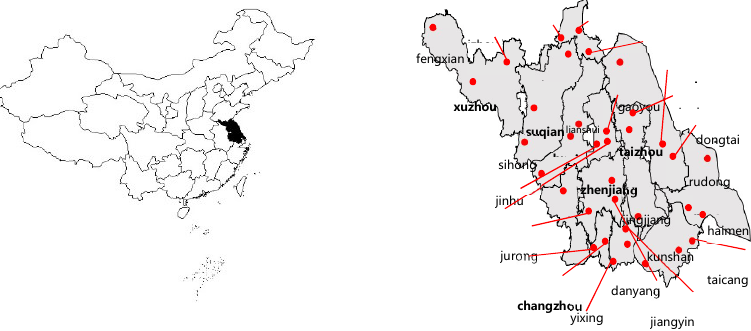
Figure 1. Research Figure 1. Research areas.